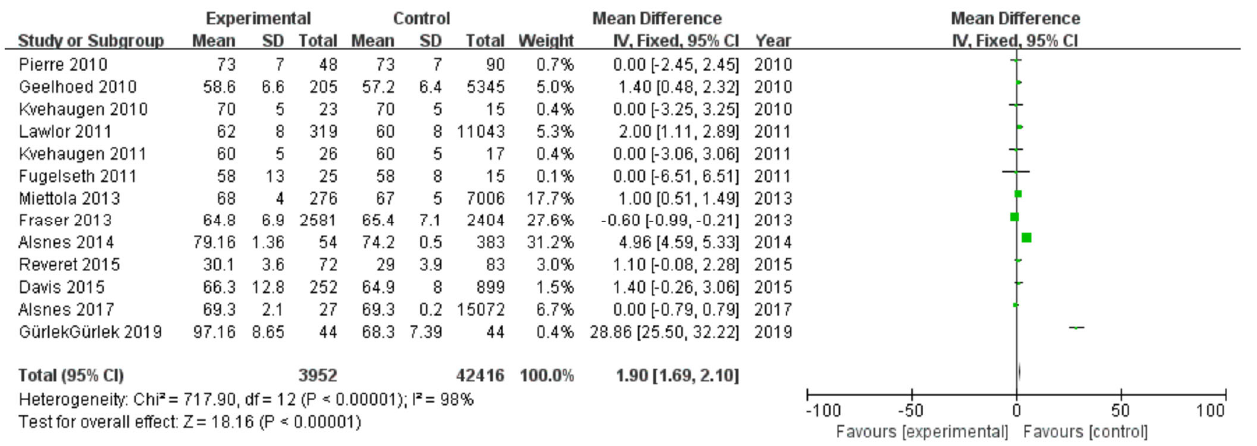
Figure 3. Meta-analysis forest map for low-density lipoprotein cholesterol of offspring of PE pregnan- Figure 3. Meta ‐ analysis forest map for diastolic blood pressure of offspring of PE pregnancies.